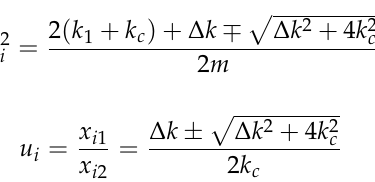
The coupling spring stiffness k c is affected by temperature; here, k c (cid:28) k , because